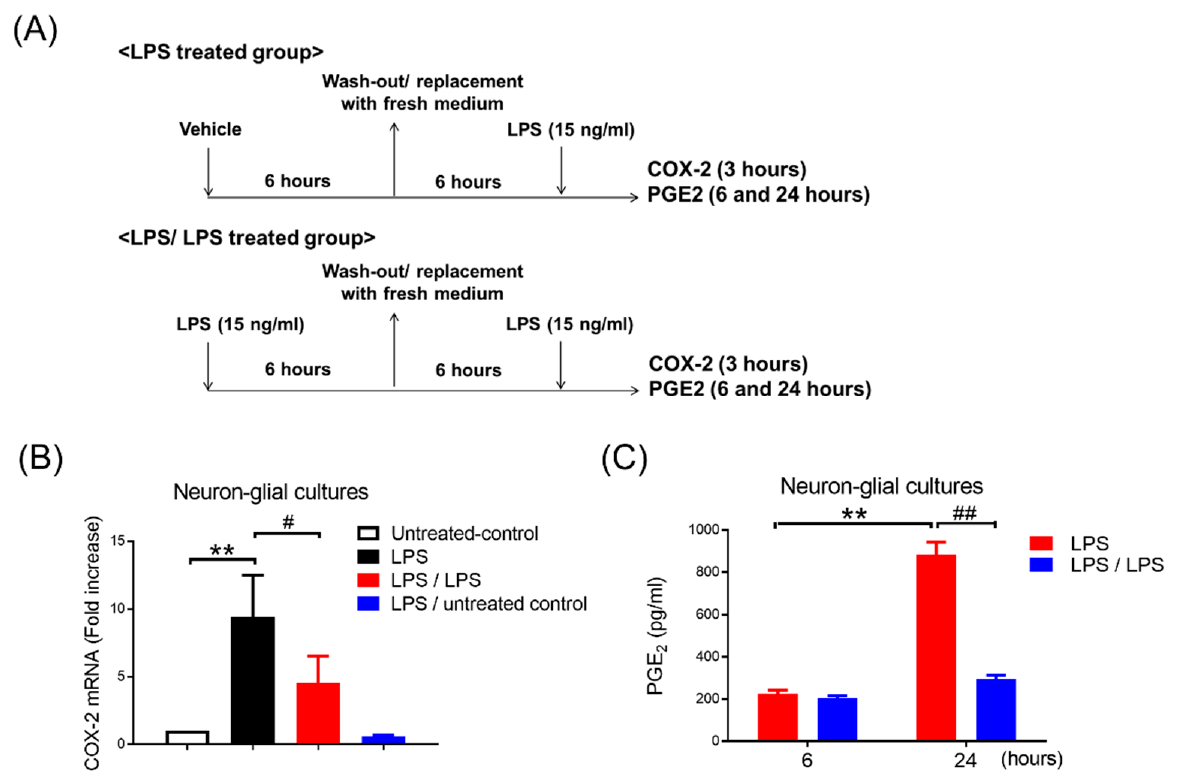
Figure 1. Reduction in COX-2 and PGE 2 expression in neuron–glial cultures in response to endotoxin tolerance. ( A ) Experimental procedure for the study of PGE 2 production in endotoxin tolerance. Neuron–glial (NG) cultures prepared from E14.5 time-pregnant C56/6J mice were pre-treated